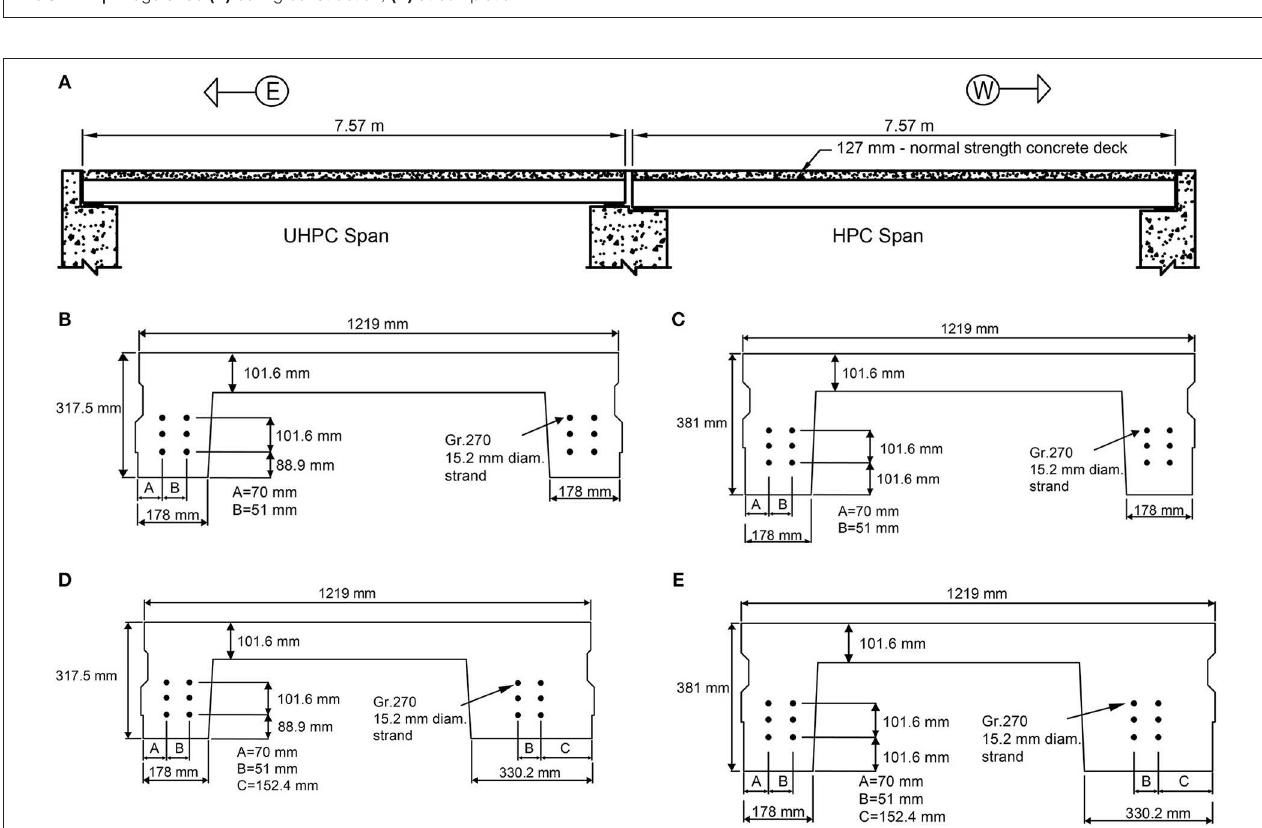
FIGURE 2 | Bridge 9706 (A) profile, (B) UHPC interior girder, (C) HPC interior girder, (D) UHPC edge girder, and (E) HPC edge girder.